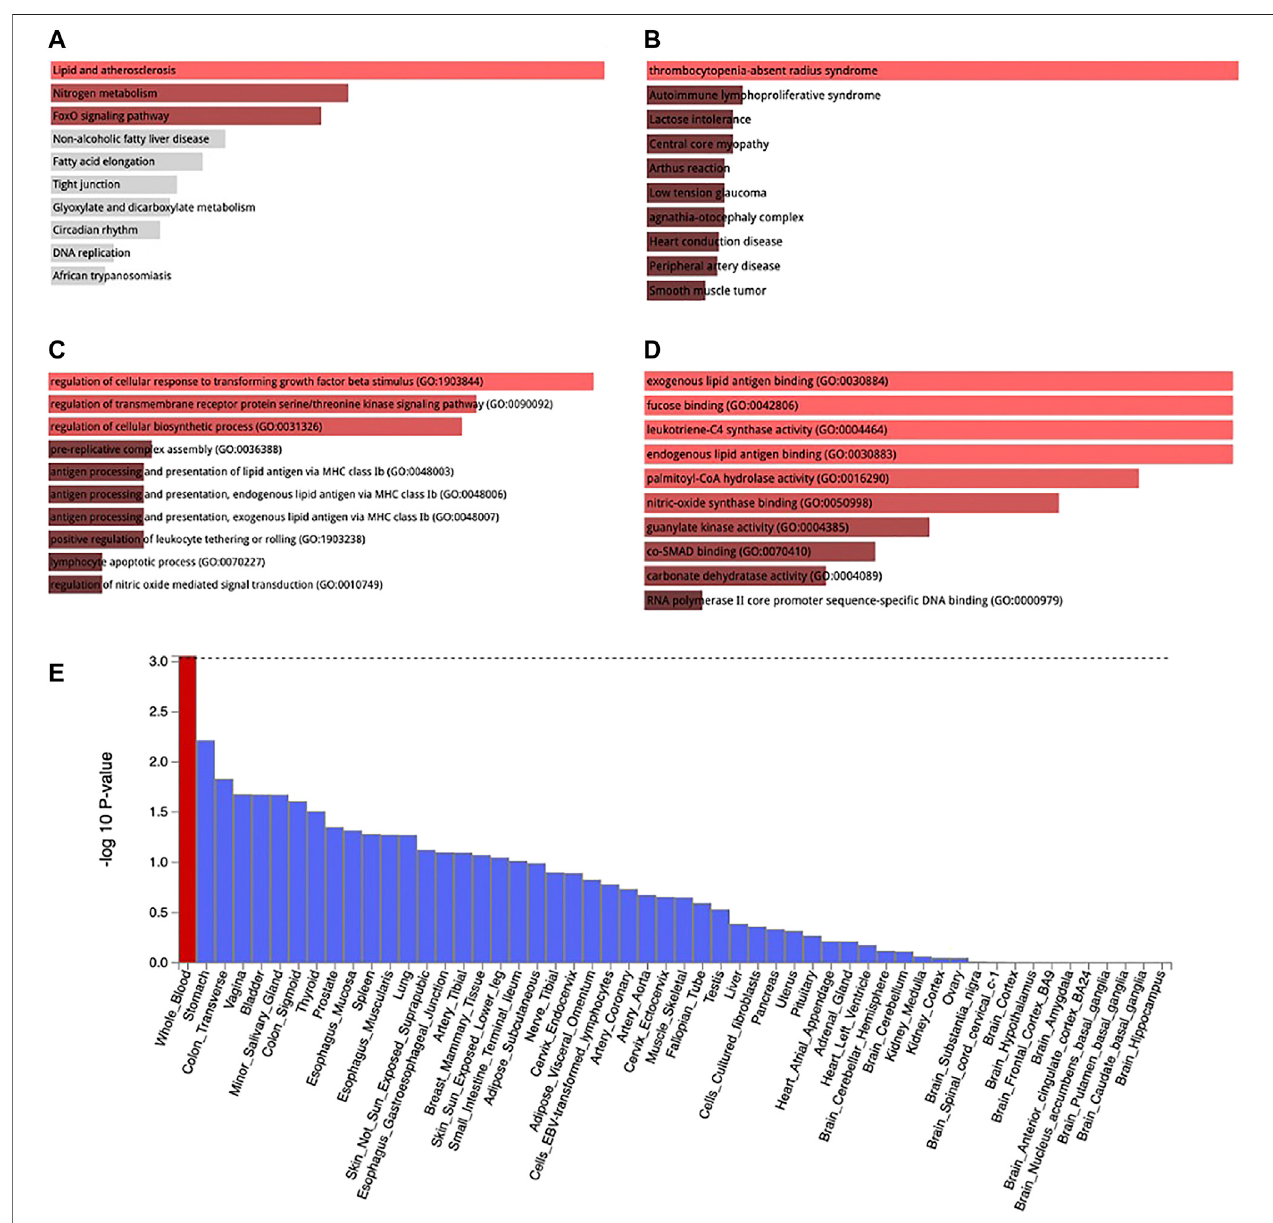
FIGURE5 | KEGG pathway enrichment (A) , Jensendisease enrichment (B) ,Biological process (C) , and Molecularfunction (D) ofthe genesassociated withWBC subtypes identi fi ed by metanalysis. Tissueexpression of enriched genes (E) . Red bar in 3 Econnotes tissues with signi fi cant enrichment while blue bars indicate tissues with no signi fi cant